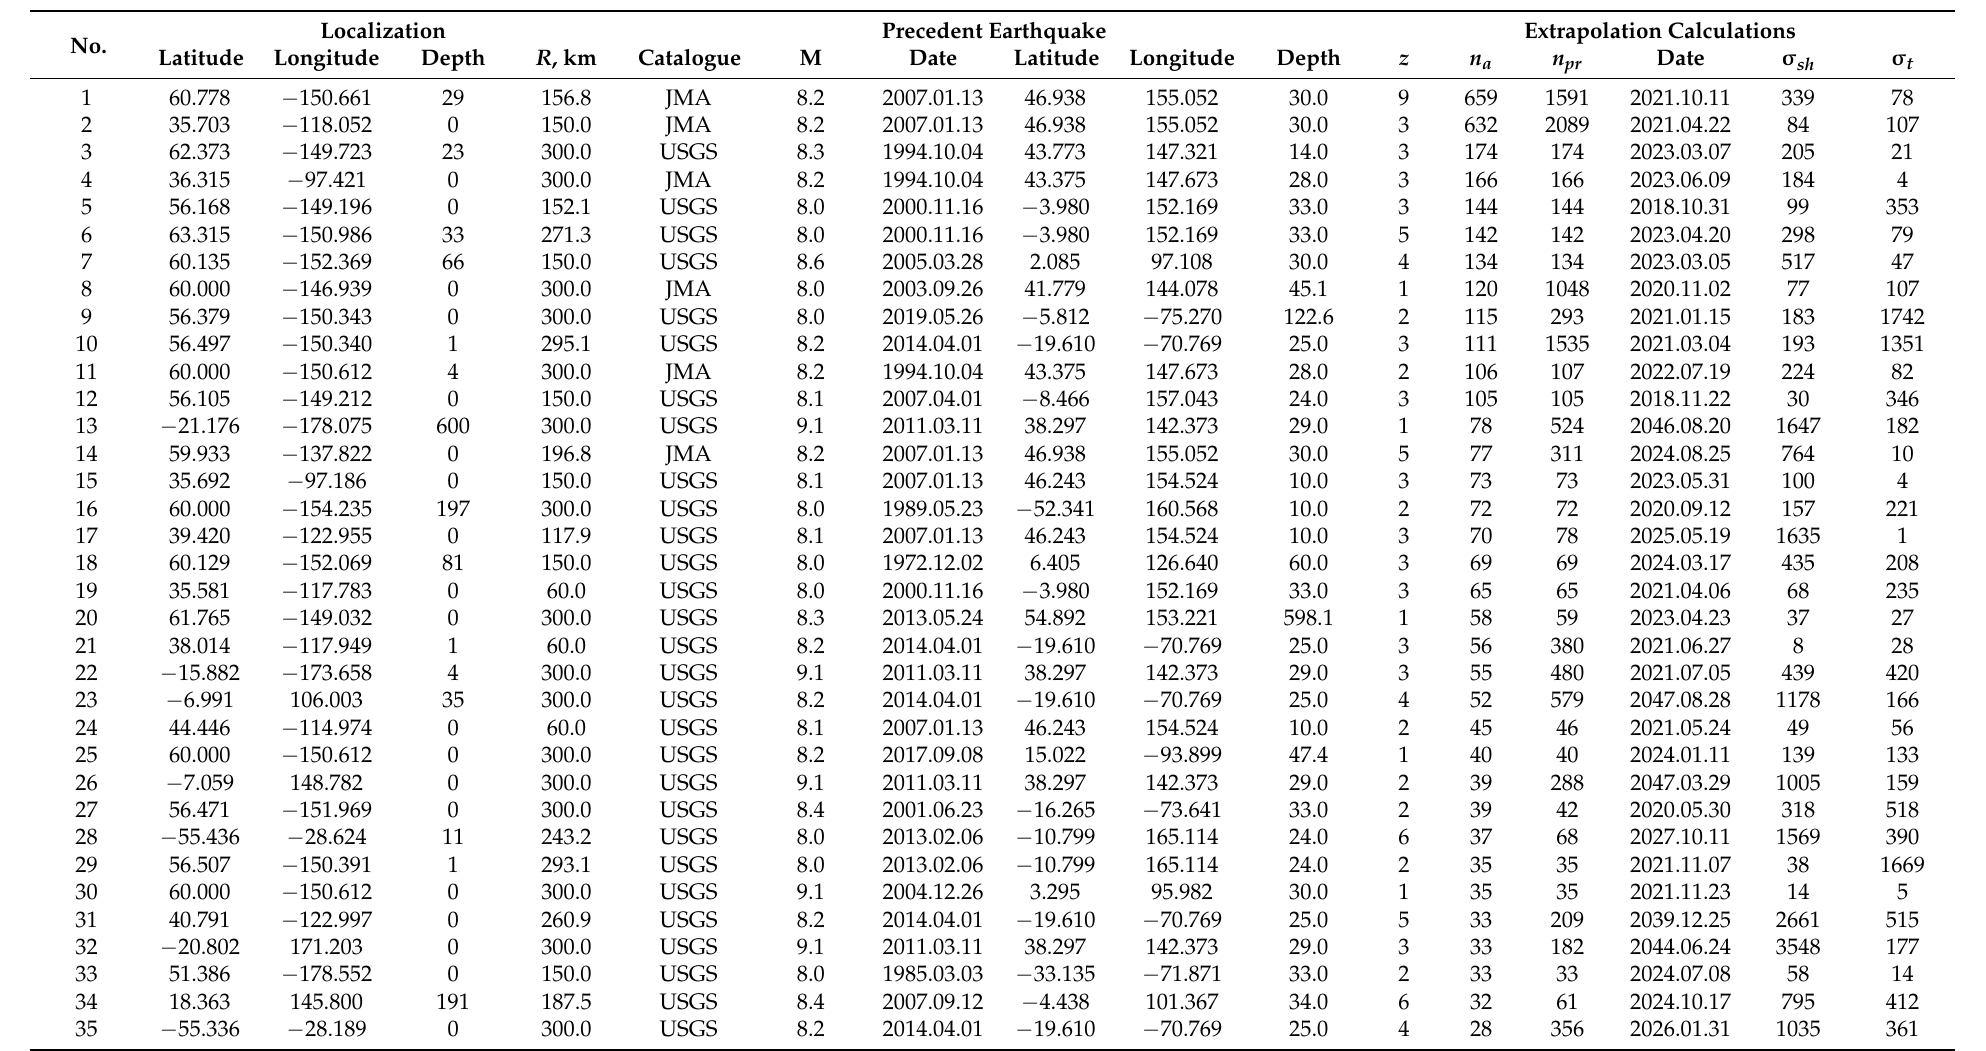
Table A13. Main clusters of hazardous activity as of 1 June